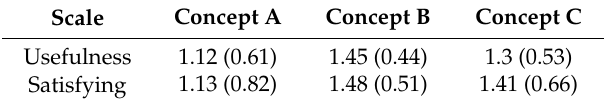
Table 2. Rated acceptance for usefulness and satisfying scale (mean and (SD) for concept A, B, and C.